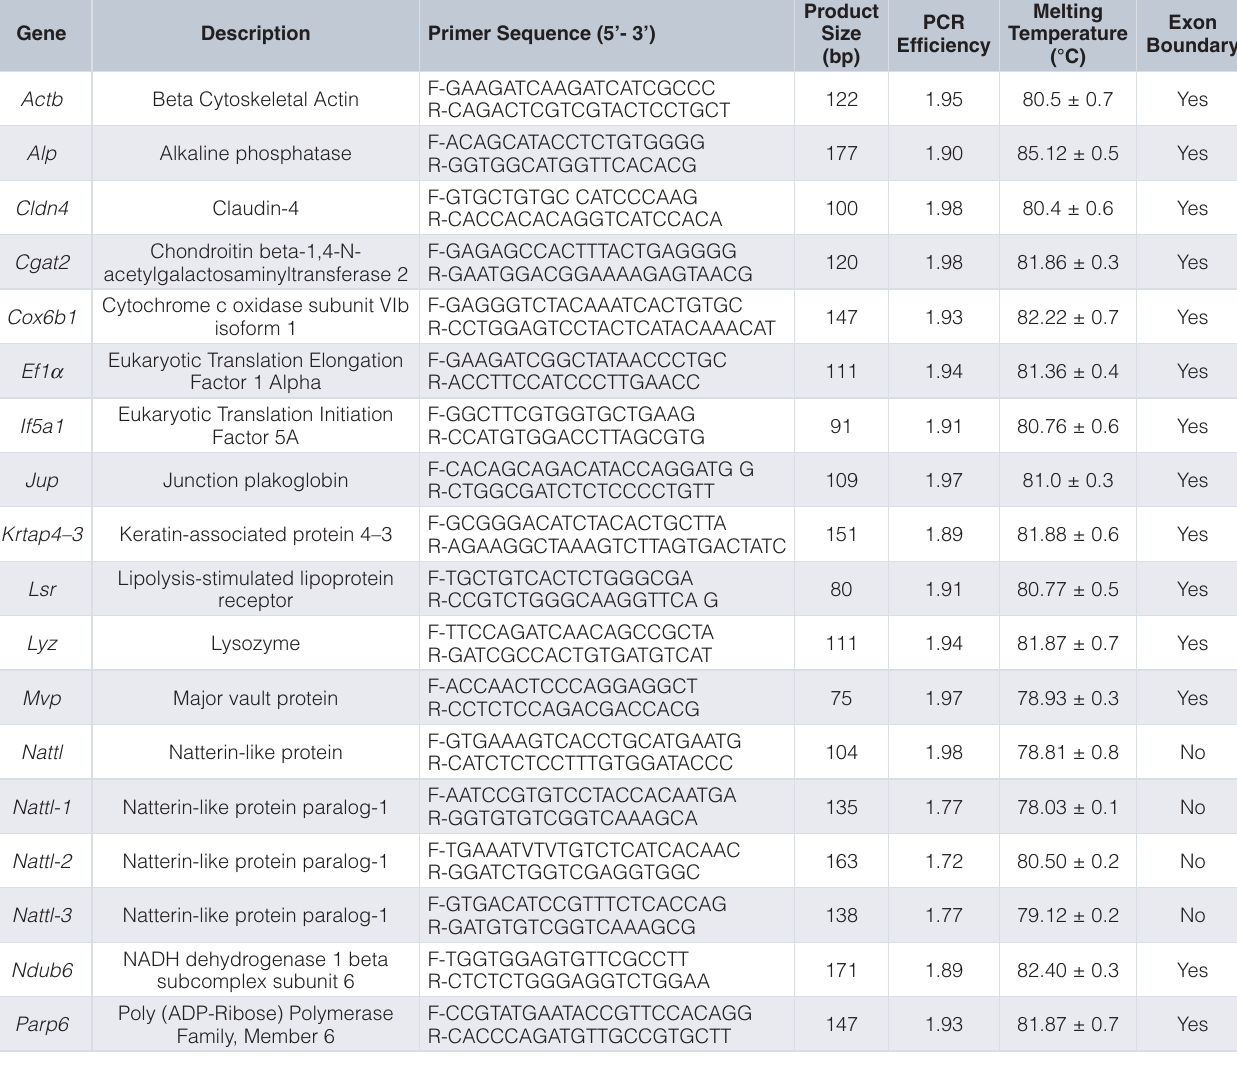
Supplemental Table S1 A. qPCR primers used in this